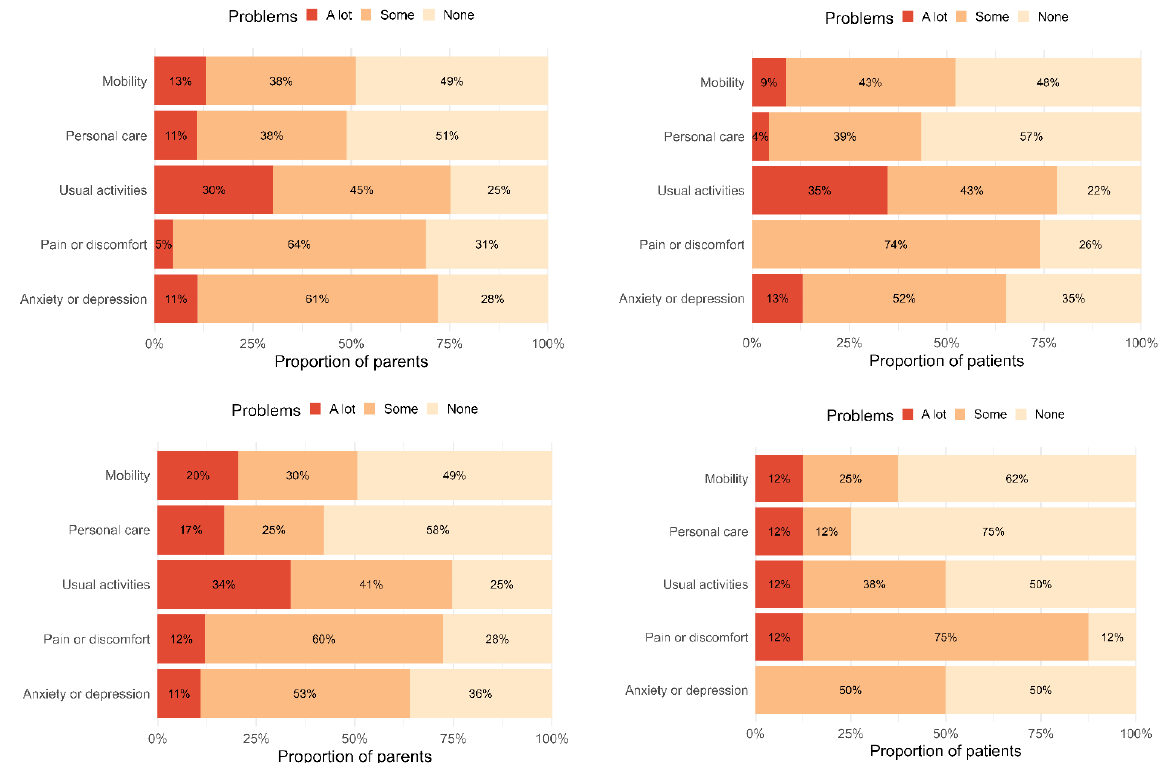
Figure 2. Patient self-report and parent-proxy QoL on EQ-5D-Y domains at T0 and T1.